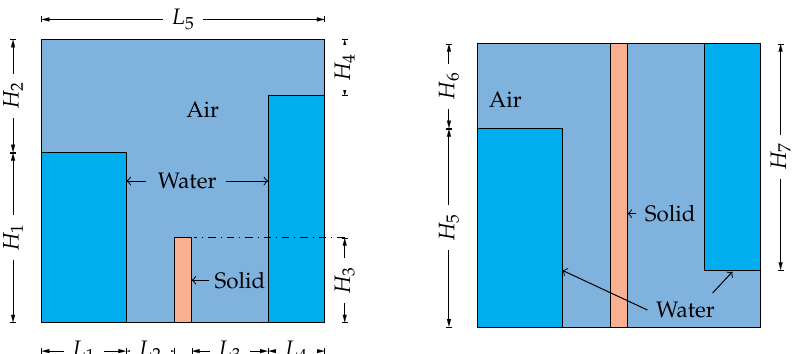
Figure 6. Domain geometry—not to scale—of the Breaking-Dam-3D test cases: front view ( left ), and top view ( right